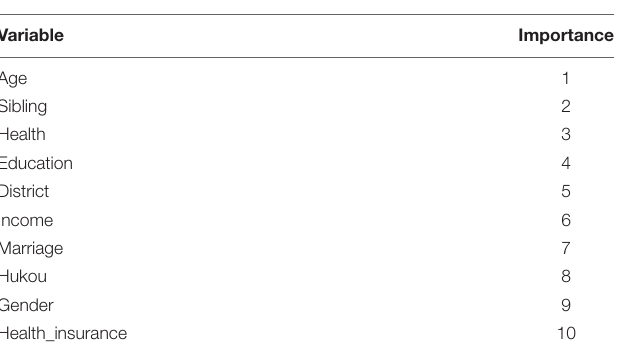
TABLE 5 | Importance of feature variables.